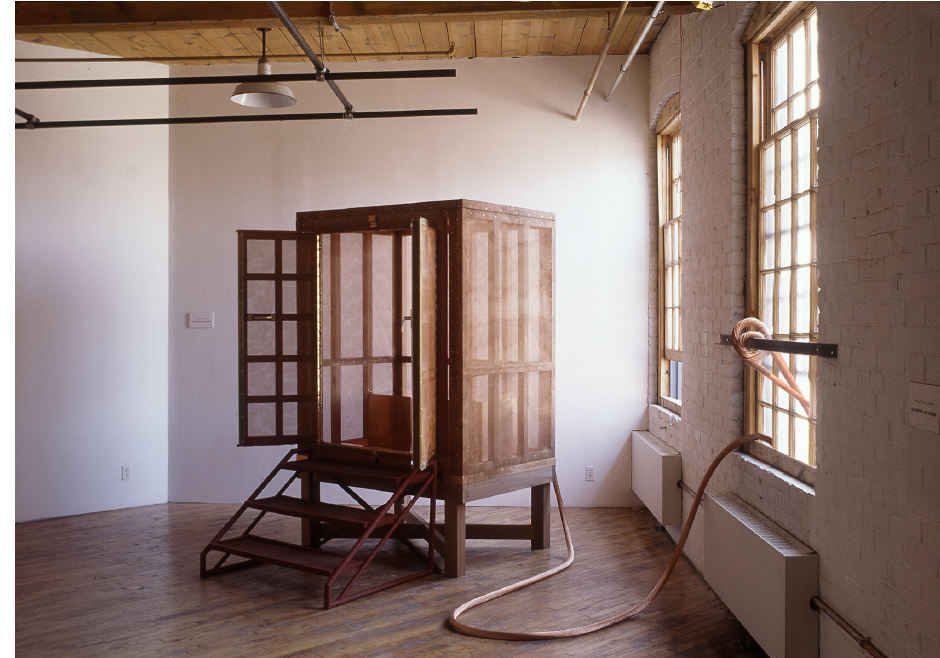
Figure 1: Catherine Richards, Cabinet of Curiosities at the End of the Millennium , 1995. Photograph courtesy of the